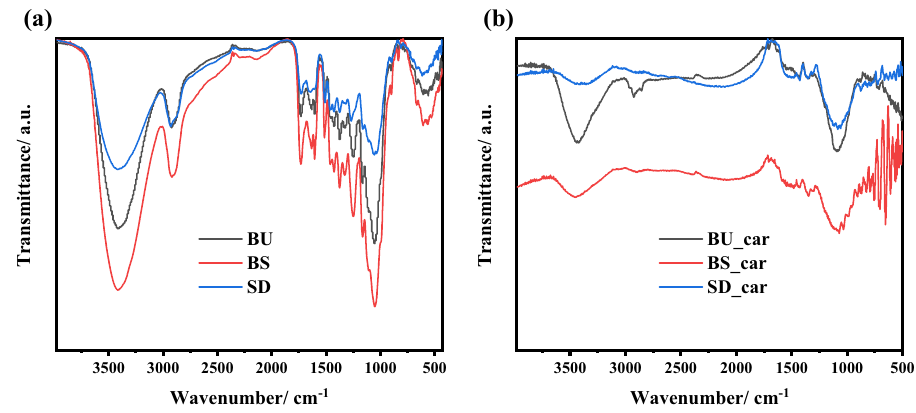
Figure 2. FTIR spectra of ( a ) BU, BS, and SD raw materials and ( b ) BU_car, BS_car, and SD_car carbonized